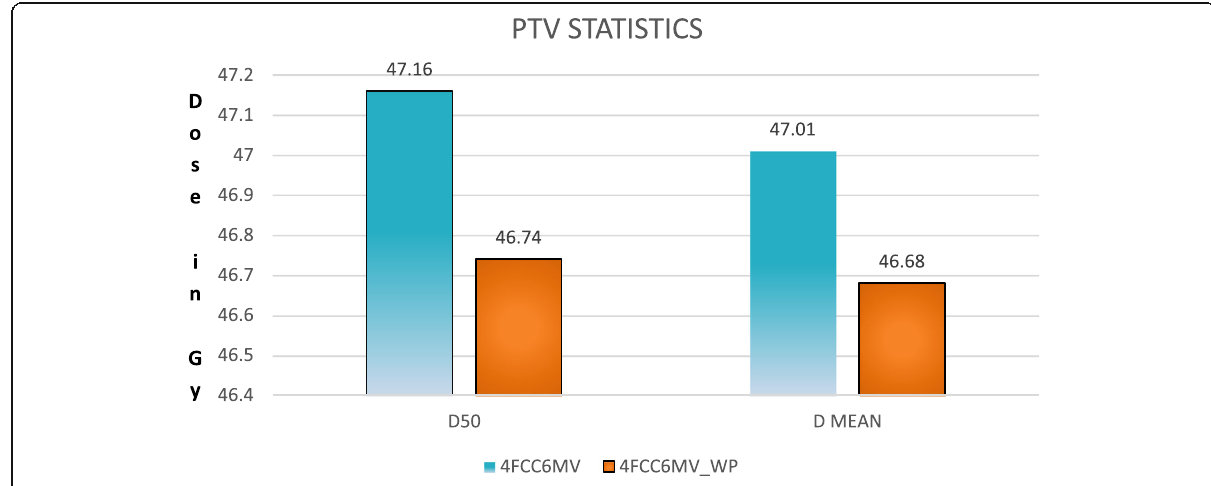
Fig. 3 PTV dose comparison for D 50 and D mean using CCC